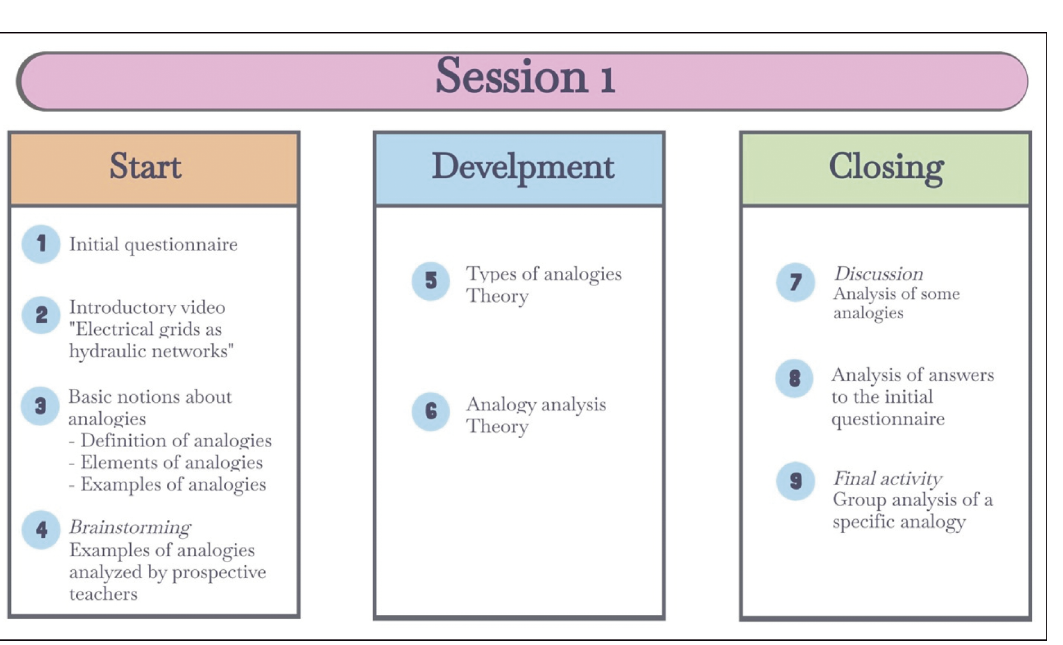
Figure 3. Development of session 1